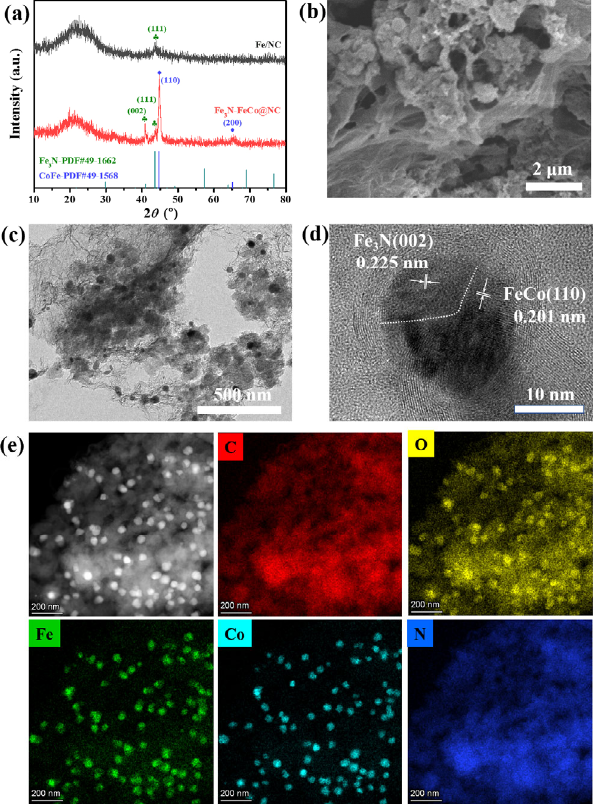
Figure 2 (a) XRD patterns, (b) SEM, (c) TEM, (d) HRTEM and (e) elemental mapping images of Fe 3